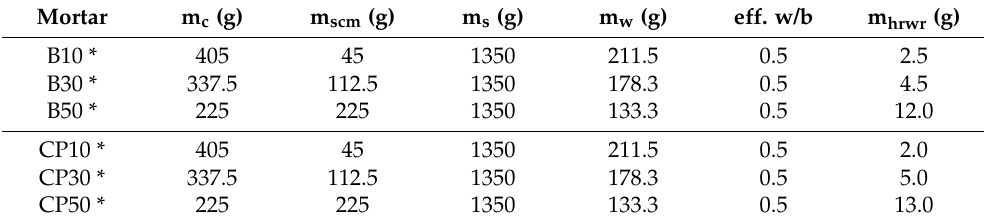
Table 2. Labels and component materials for mortars and the effective w/b.